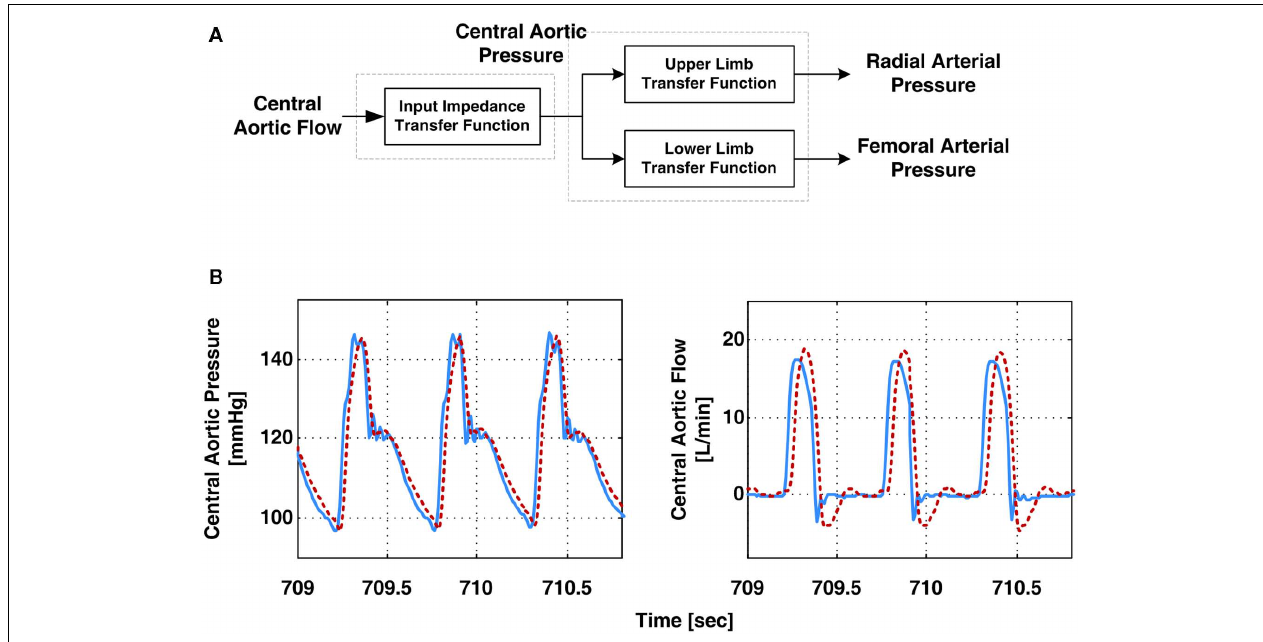
FIGURE 10 | (A) Block diagram of derivation of the aortic pressure and central aortic flow waveforms from radial and femoral arterial pressure waveforms. (B) Measured (solid) and derived (dash) waveforms. Adapted from Hahn et al.